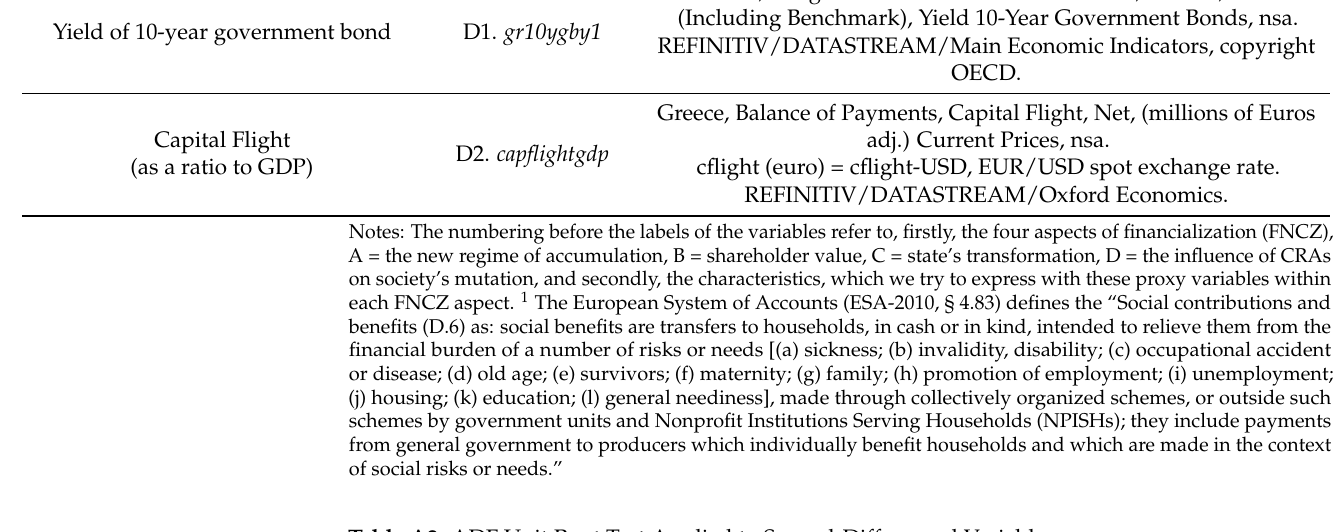
Table A2. ADF Unit Root Test Applied to Second-Differenced